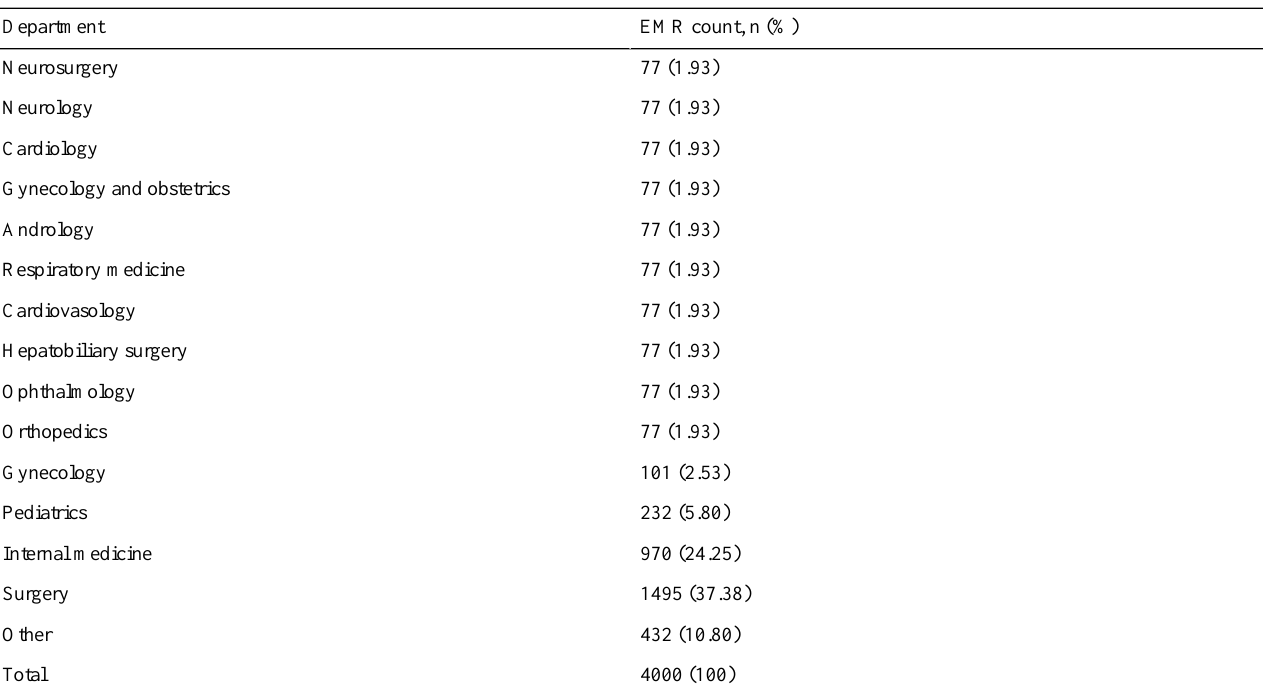
Table 1. Electronic medical record (EMR) data distribution by